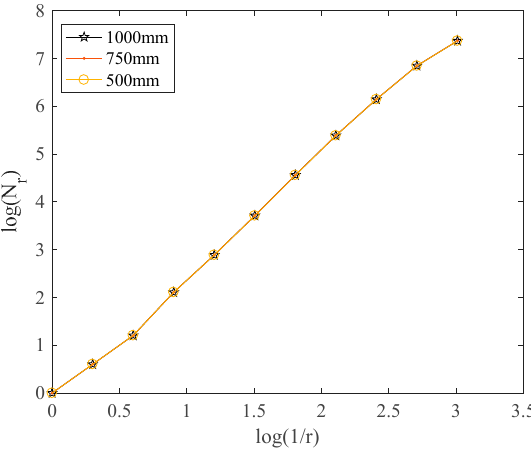
Figure 7. Fractal dimensions at different heights.